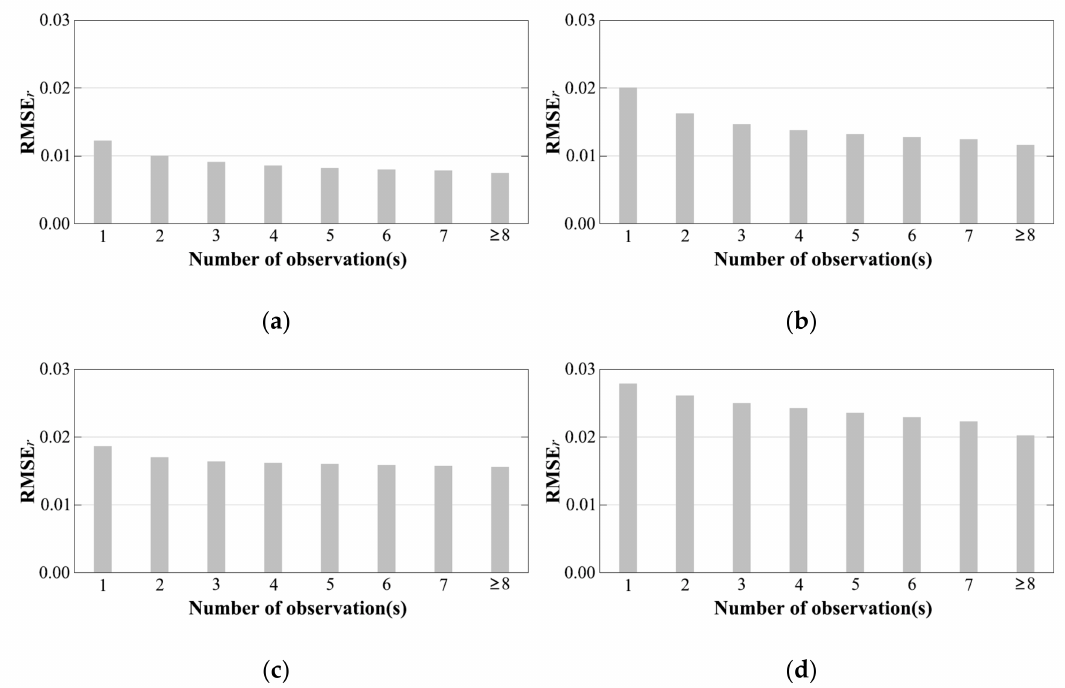
Figure 16. The change in RMSE r with different number of observations. ( a ) Retrieval results are based on observations within 2021.101-116, and ( c ) based on observations within 2021.305-320 in the red band; ( b , d ) are in the NIR